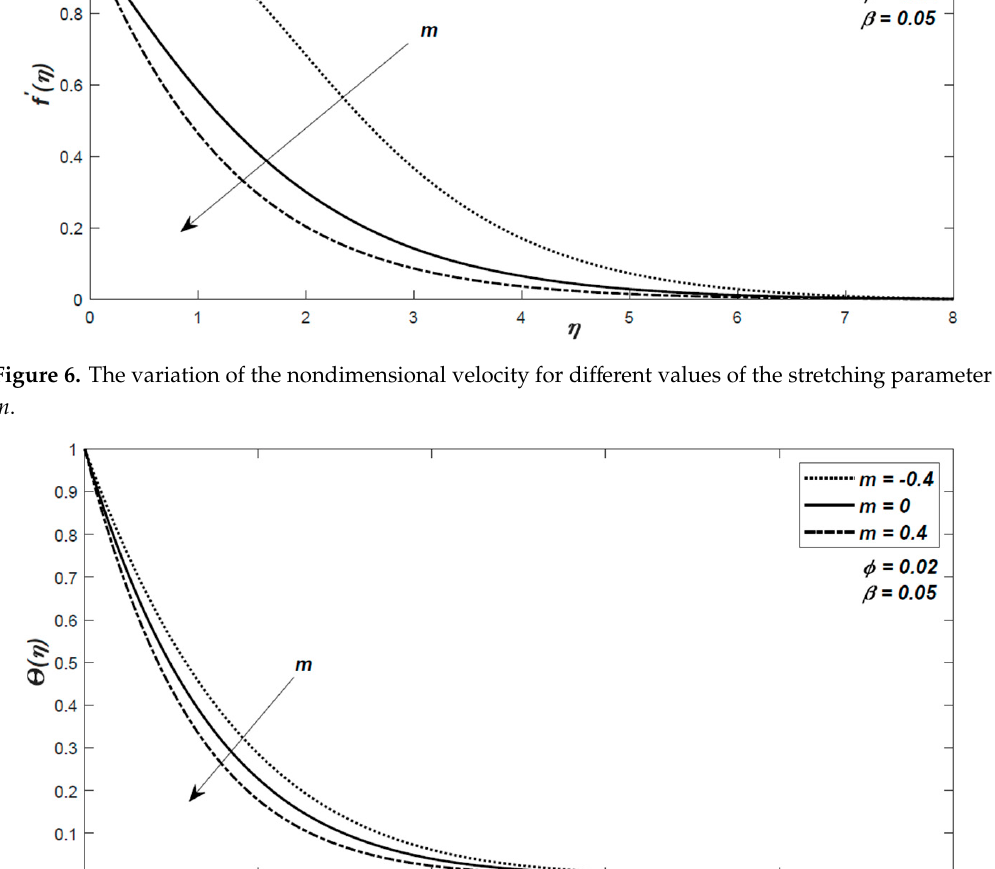
Figure 6. The variation of the nondimensional velocity for different values of the stretching parameter (cid:1865)